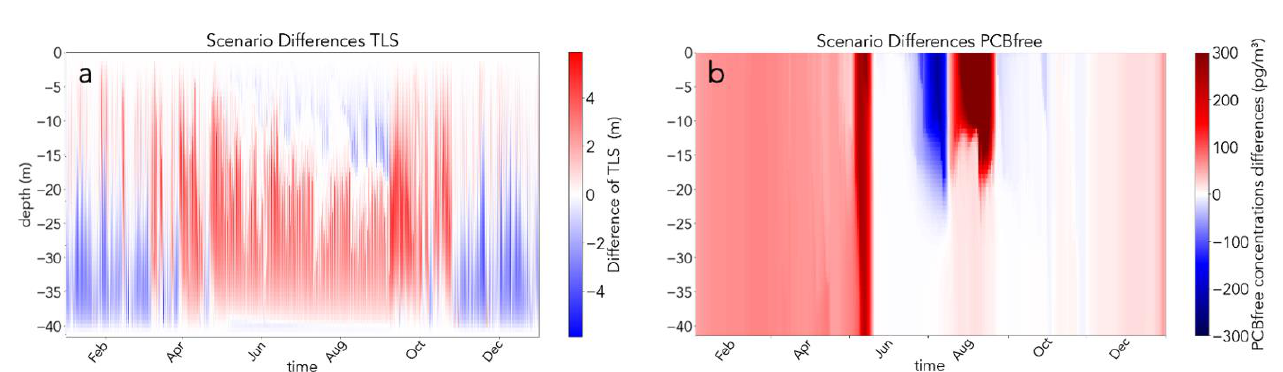
Figure 14. Results of simulations for: ( a1 , a2 , a3 ) no-tide scenario, ( b1 , b2 , b3 ) tide scenario (SNS, 2001 year). Concentrations of: ( a1 , b1 ) PCB DOM (pg m − 3 ); ( a2 , b2 ) freely dissolved PCB 153 (pg m − 3 ); ( a3 , b3 ) atmospheric flux of PCB 153 (pg m − 2 s − 1 ) (direction of flux—from atmosphere to water).